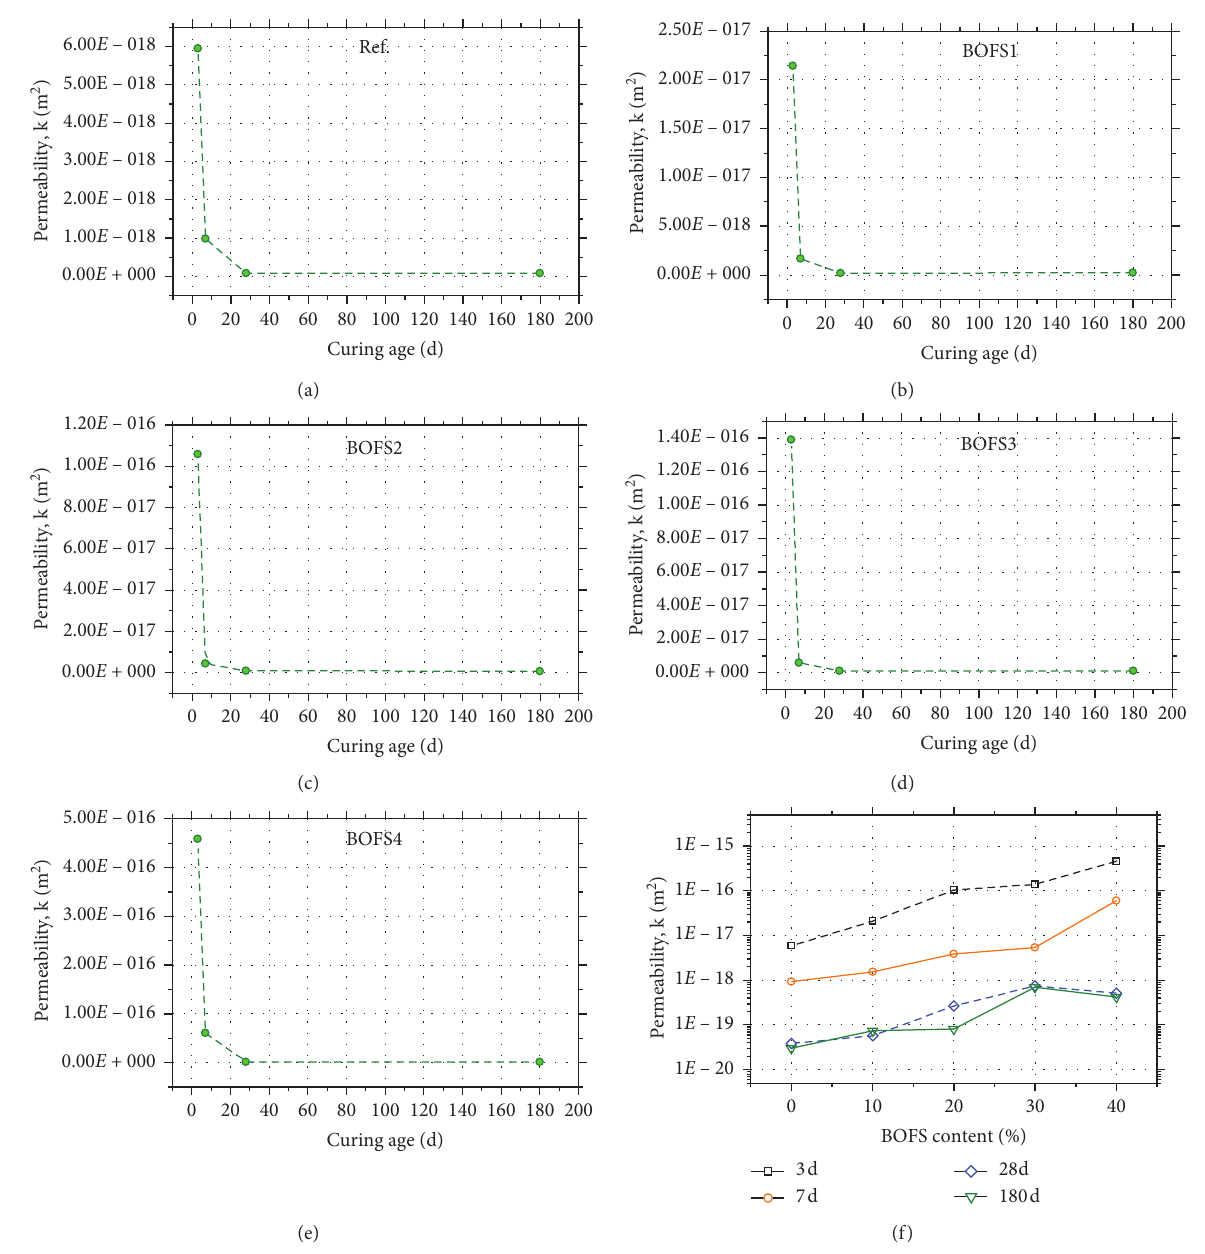
Figure 9: Permeability of cement pastes with